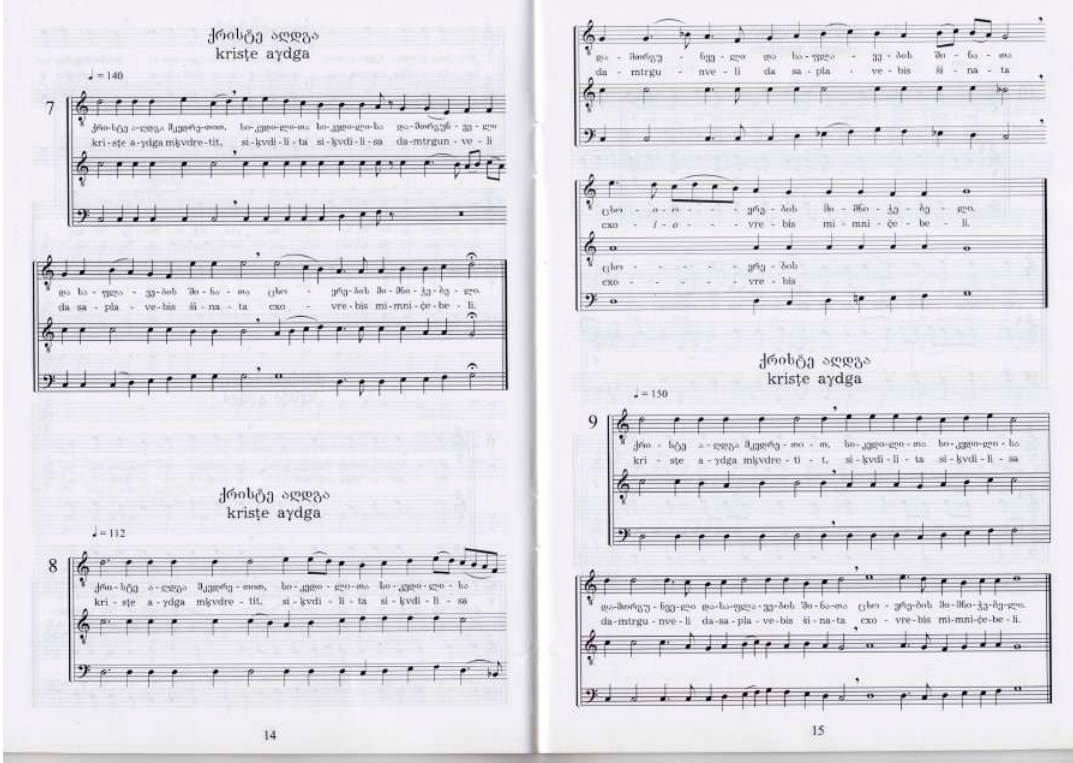
Figure 4. Paschal troparion; Shemokmedi School.